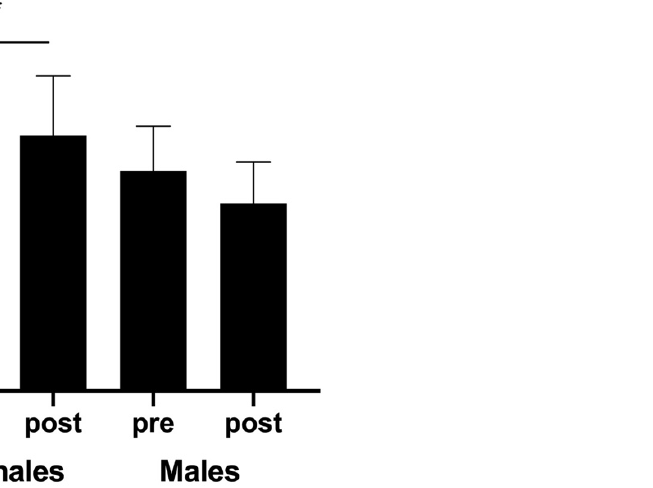
Figure 4. Blood IR concentrations (ng/mL) measured before and after padel competition. Finally, a correlation analysis reported significant associations between BDNF and IR for the entire group in both before (rho = 0.461; p = 0.024), and after competition (rho = 0.665; p < 0.001).